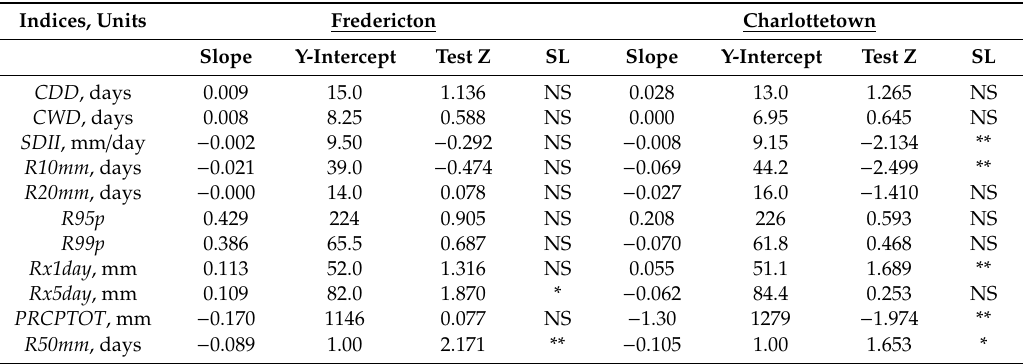
Table 4. Results of the Mann–Kendall trend analysis and Sen’s slope estimate to show trend line parameters and significance levels for the calculated trends of precipitation extremes of Fredericton and Charlottetown during the 100 years period of